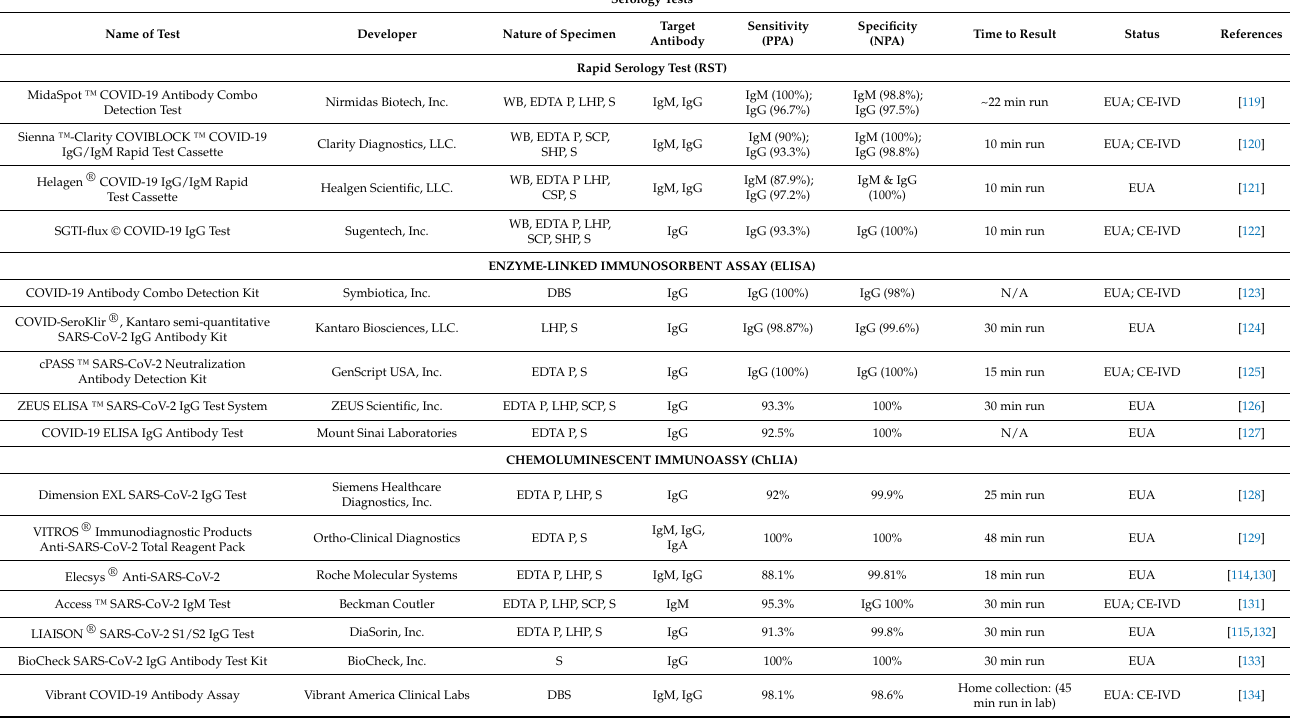
Table 3. Comparative list of serology tests for the detection of SARS CoV-2 by manufacturer, origin of specimen, target antibody, sensitivity, specificity and the time to produce one successful